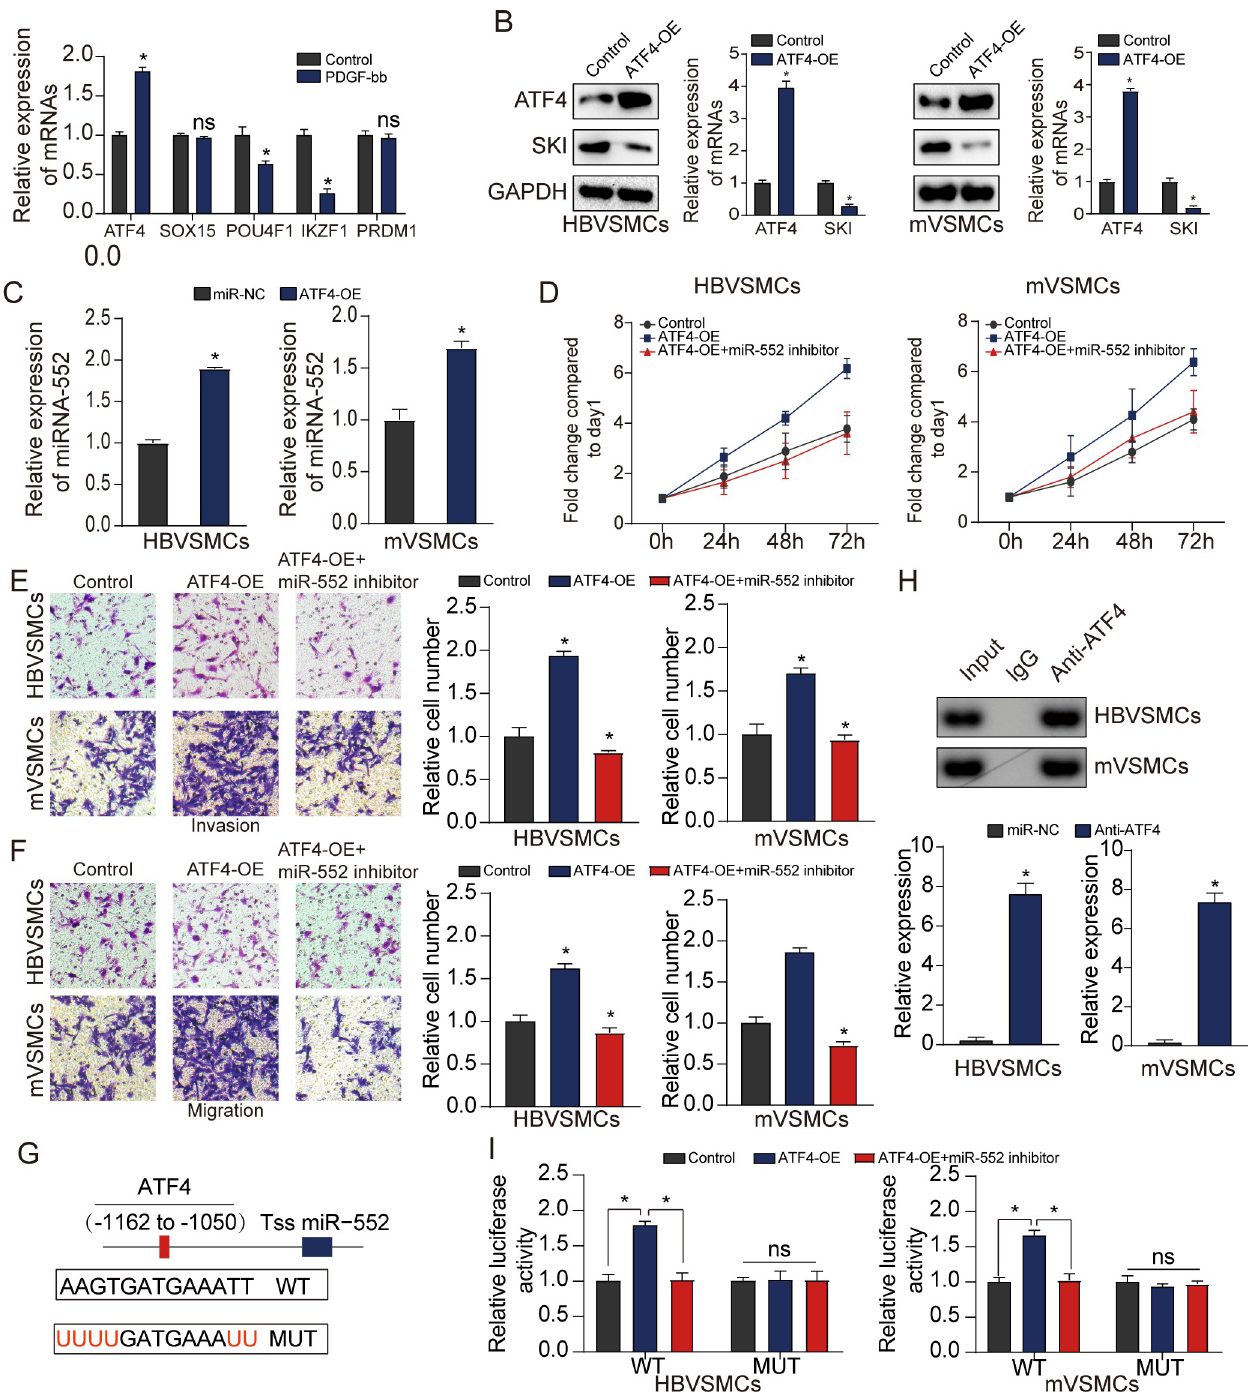
Fig 5. MiR-552 is a target gene of ATF4 in VSMCs. (A ) qRT-PCR assay was conducted to assess the expression level of the top five TFs expression. (Student’s t test) ( B ) The impact of ATF4 elevation on SKI in HBVSMCs and mVSMCs was tested with western blot assay. (Student’s t test) (C ) The effect of ATF4 overexpression on miR-552 level in HBVSMCs and mVSMCs was tested on the basis of qRT-PCR assay. (Student’s t test) ( D) Impact of ATF4 and miR-552 on proliferation of HBVSMCs and mVSMCs in accordance to MTT analysis. ( E, F ) Impact of ATF4 and miR-552 on the invasion and migration of HBVSMCs and mVSMCs was assessed using transwell assay. (G) A schematic was used to illustrate the proximal region of the miR-552 promoter based on ChIP assay. ( H) ChIP assay was applied to manifest the binding association between ATF4 and the miR-552 promoter in HBVSMCs and mVSMCs. ( I ) The luciferase activity in the WT miR-552 promoter was elevated in HBVSMCs and mVSMCs with ATF4 upregulation and this effect could be rescued when they were transfected with miR-552 inhibitor. whereas no change was found in luciferase activity with mutation of ATF4 binding site at -1162 to -1050bp in of the